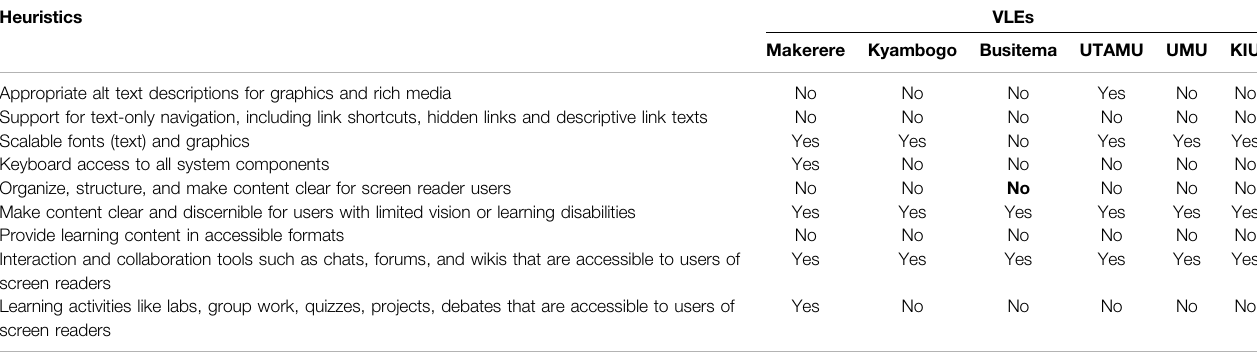
TABLE 5 | Summary Results from Expert Evaluation using Heuristics. Heuristics